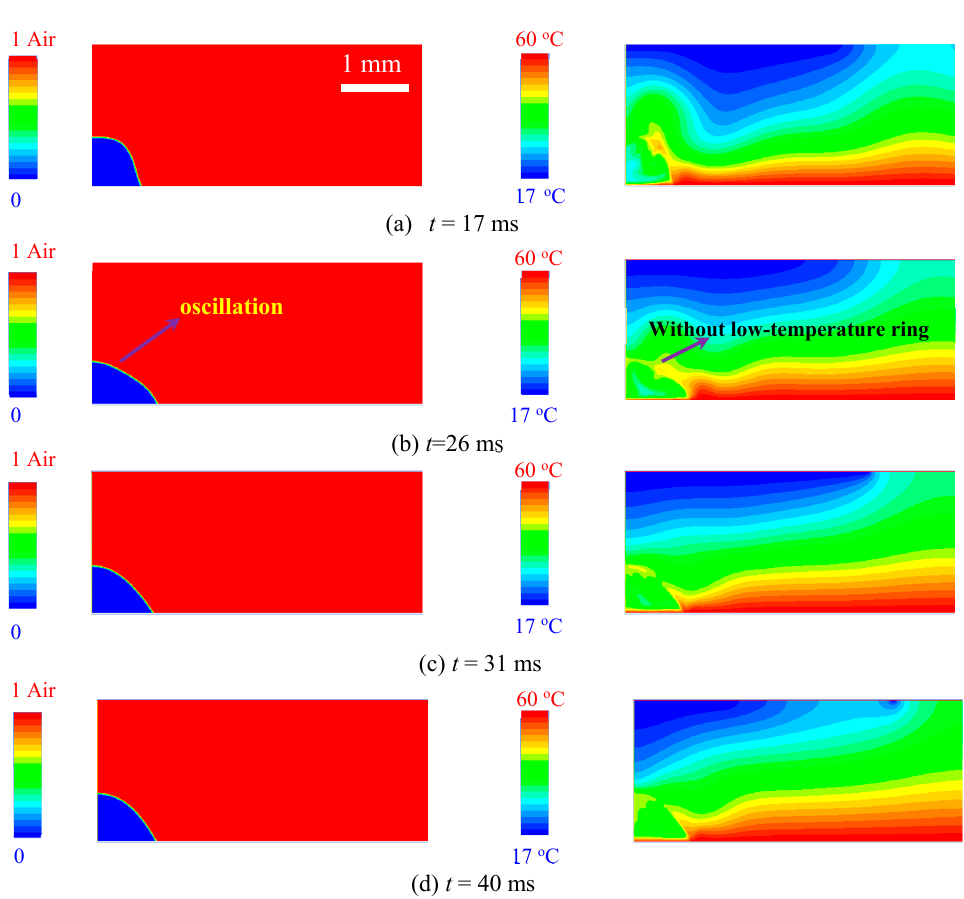
Figure 11 和 Figure 12 麻烦更换以下清晰图片